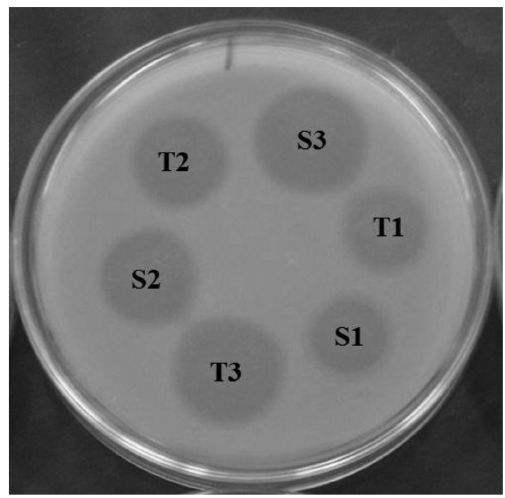
FIGURE 1 - CFTX potency evaluation by agar diffusion assay using the cylinder-plate method with a 3 x 3 experimental design. Zones of growth inhibition observed for doses 16,